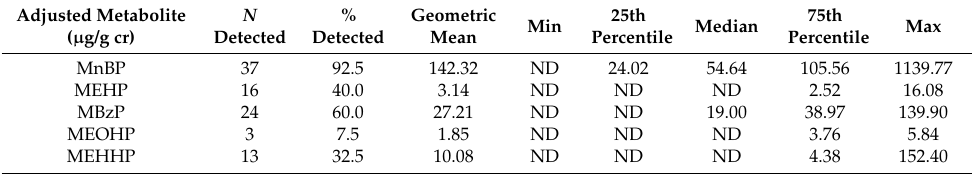
Table 2. Concentrations of phthalate creatinine adjusted metabolites ( µ g/g cr) in urine samples. Adjusted Metabolite ( µ g/g